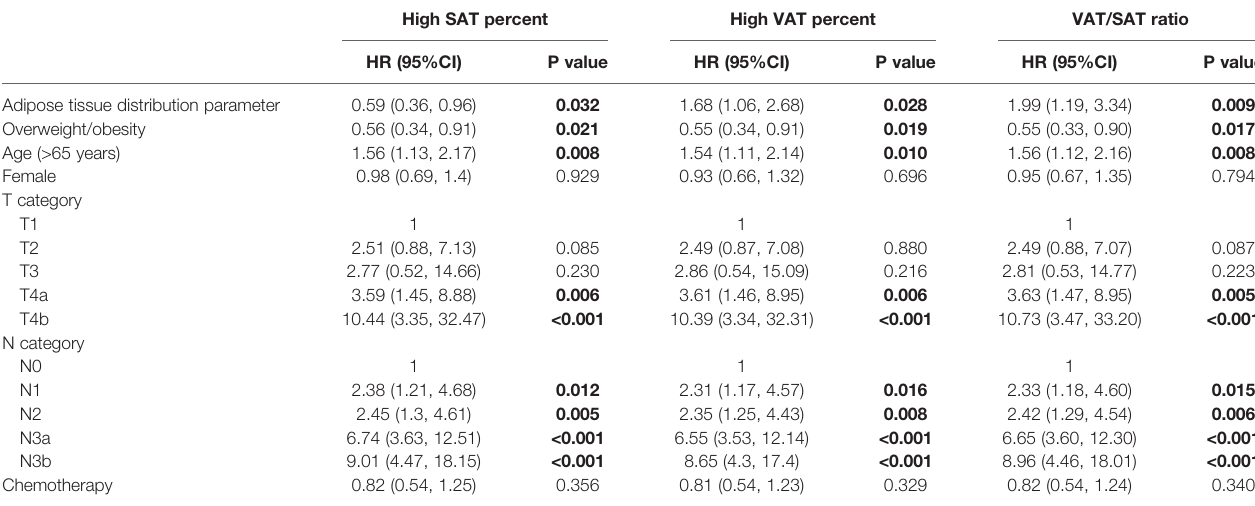
TABLE 3 | Associations between adipose tissue distribution parameters and disease-speci fi c survival by multivariate Cox analysis in patients with gastric cancer. High SAT percent High VAT percent VAT/SAT ratio